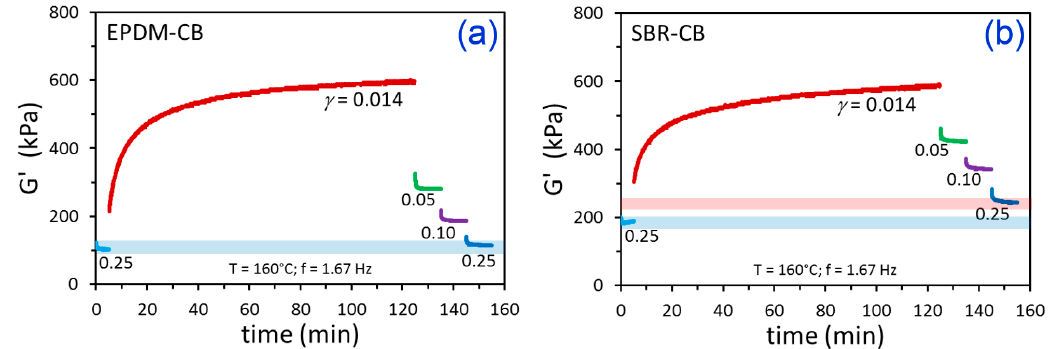
Figure 2. Time-dependent G’ results for the indicated strain amplitude history for EPDM-CB ( a ) and SBR-CB ( b ). The blue bar in ( a ) represents the similar starting and ending values of G’ at γ = 0.25. In ( b ), the blue bar is the starting G’ at γ = 0.25 and the pink bar is the final G’ at γ = 0.25, which is higher.